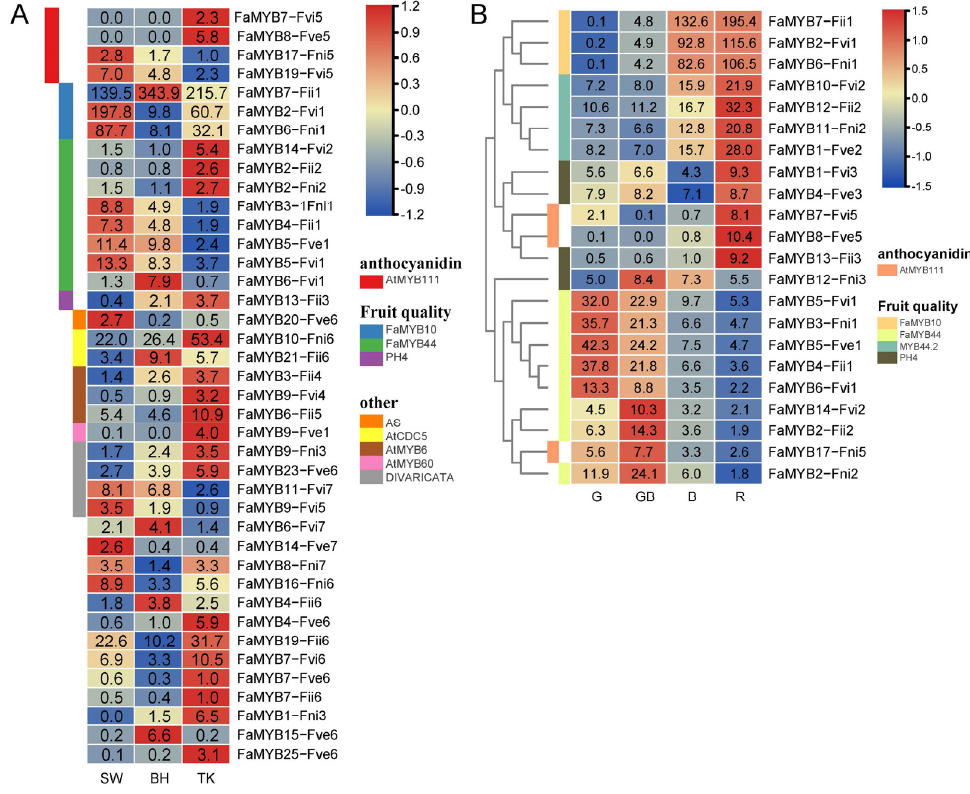
Figure 4. FaMYBs expression profiles of 3 strawberry cultivars ( A ) and 4 ripening processes ( B ). The rows represented FaMYBs . The strawberry cultivars ‘Benihoppe’ (BH), ‘Tokun’ (TK) and ‘Snow White’ (SW) and ripening processes of TK. (i) the stage of green fruit (G), (ii) the stage of fruit turning green to white (GW), (iii) the stage of white fruit (W) and (iv) the stage of red fruit (R) are labeled on the columns. Numbers in boxes are TPM (transcripts per kilobase of exon model per million mapped reads) values, and normalized TPM are converted to the gradient colors. FaMYBs of ( B ) are clustered by hierarchical clustering of Euclidean distance. FaMYBs homologous genes and corresponding function are marked by legends.